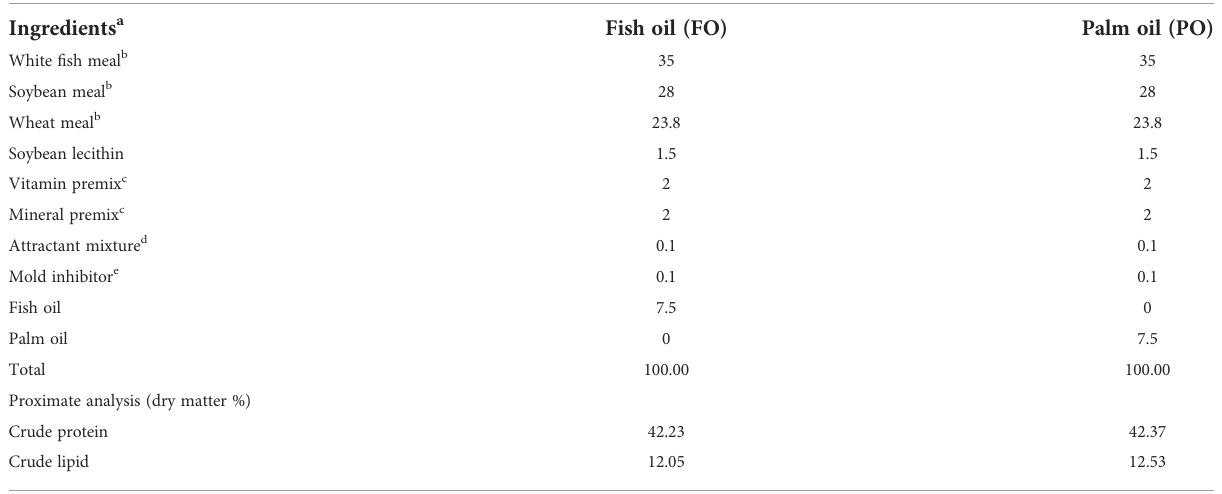
TABLE 1 Formulation and proximate composition of experimental diets (% dry weight)